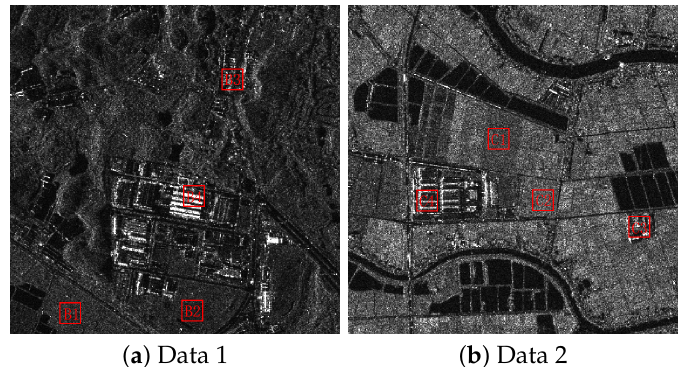
Figure 9. Two real SAR images with unknown L : ( a , b ) Data 1 and Data 2, respectively.